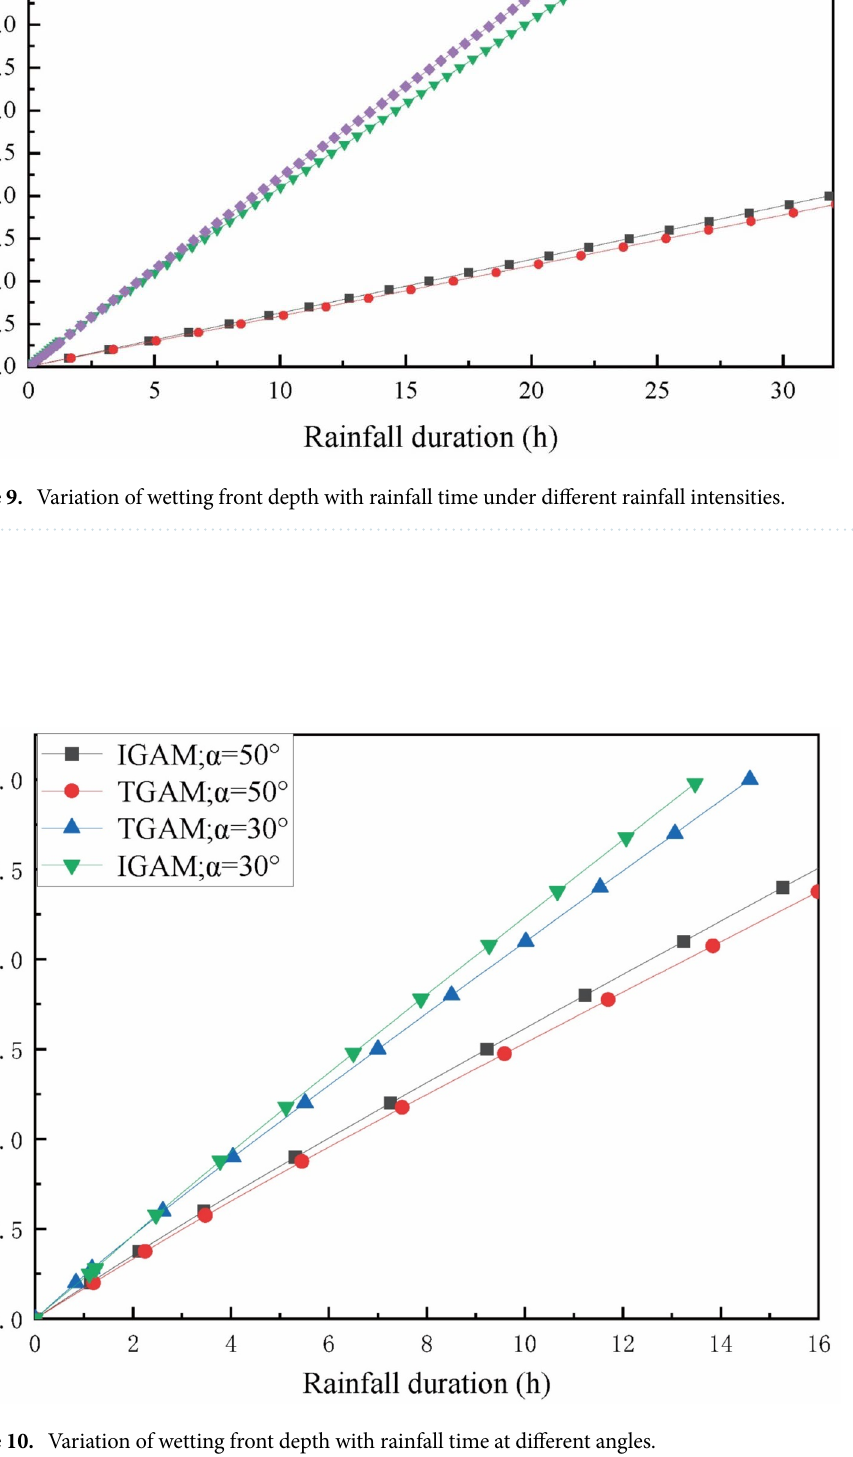
Figure 10. Variation of wetting front depth with rainfall time at different